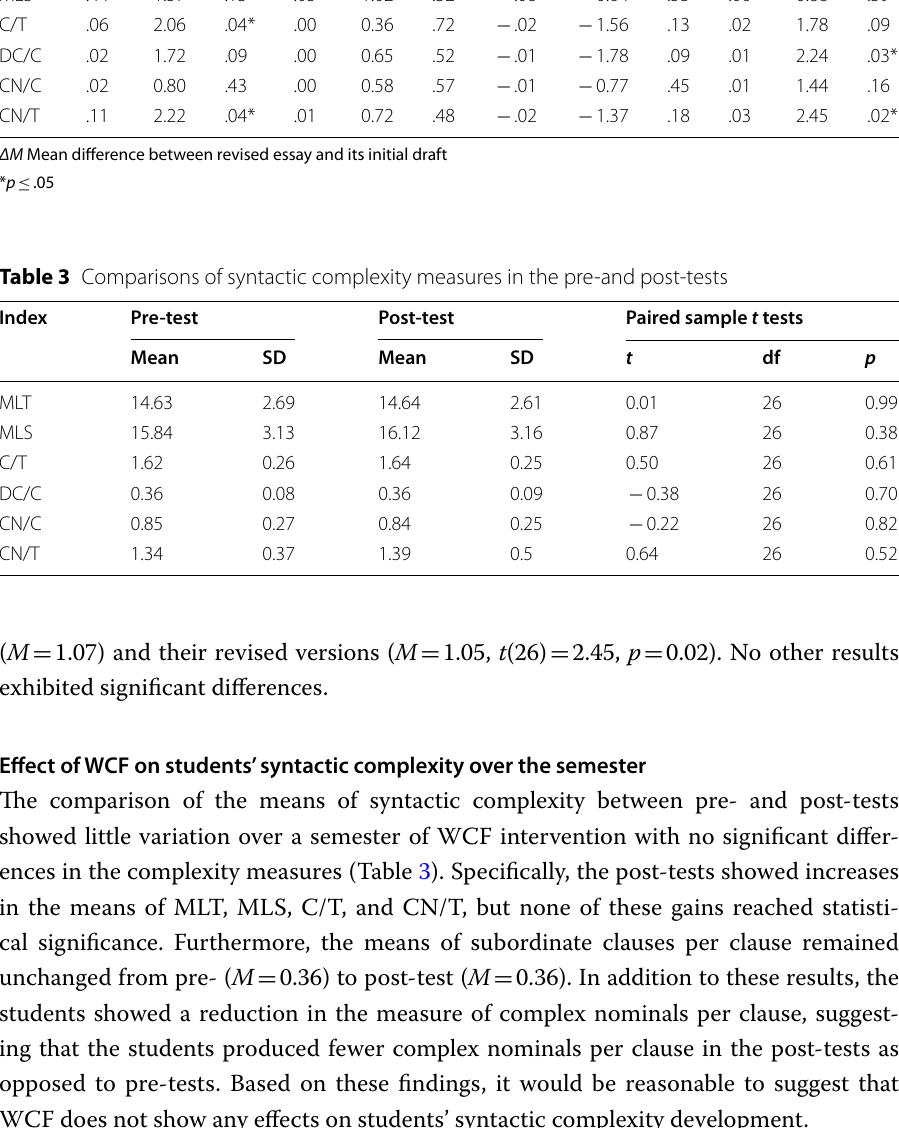
Table 2 Paired sample t -tests of syntactic complexity gains between the initial and revised essays